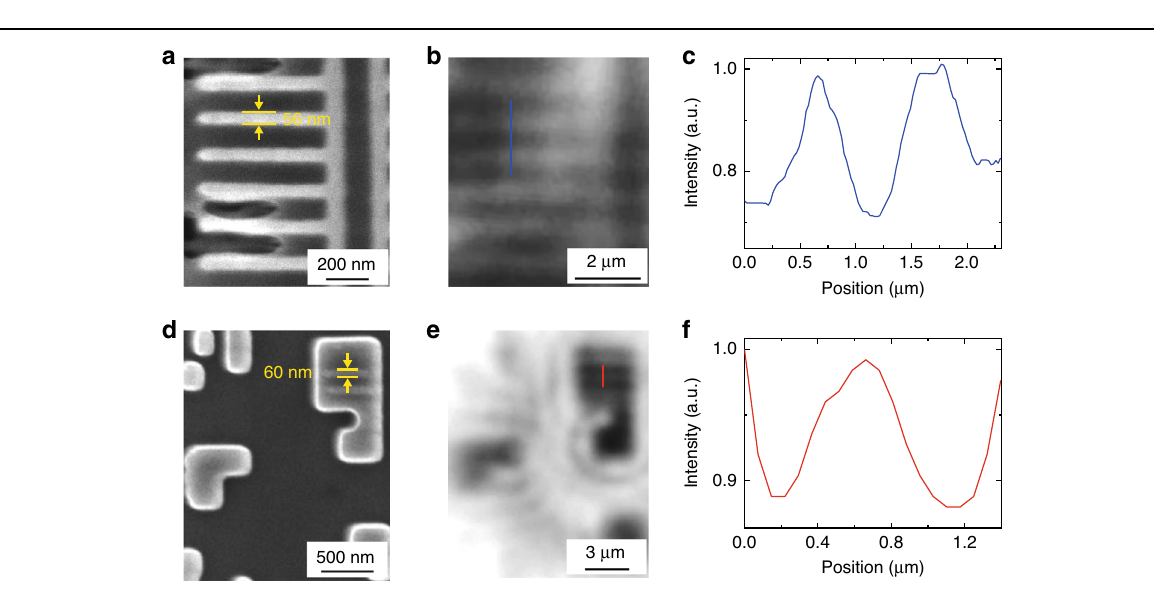
and gaps between them are well resolved as displayed in Fig. 7c. Functional devices on the bottom layer of the chip can also be observed as shown in Fig. 7d, e. Speci fi cally, features with 60 nm linewidth on the “ knife-shaped ” device are discerned as shown in the intensity pro fi les displayed in Fig. 7f. These imaging results for the CPU chip demonstrate the potentials of the proposed technique for semiconductor industrial applications.